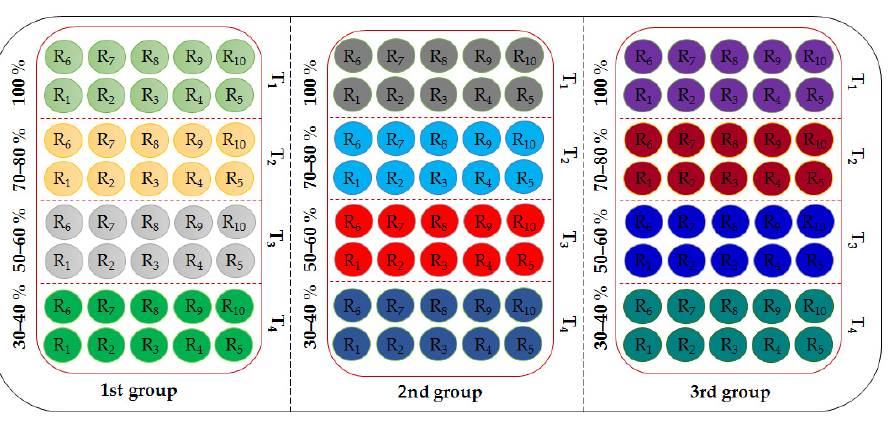
Figure 1. An experimental design layout.